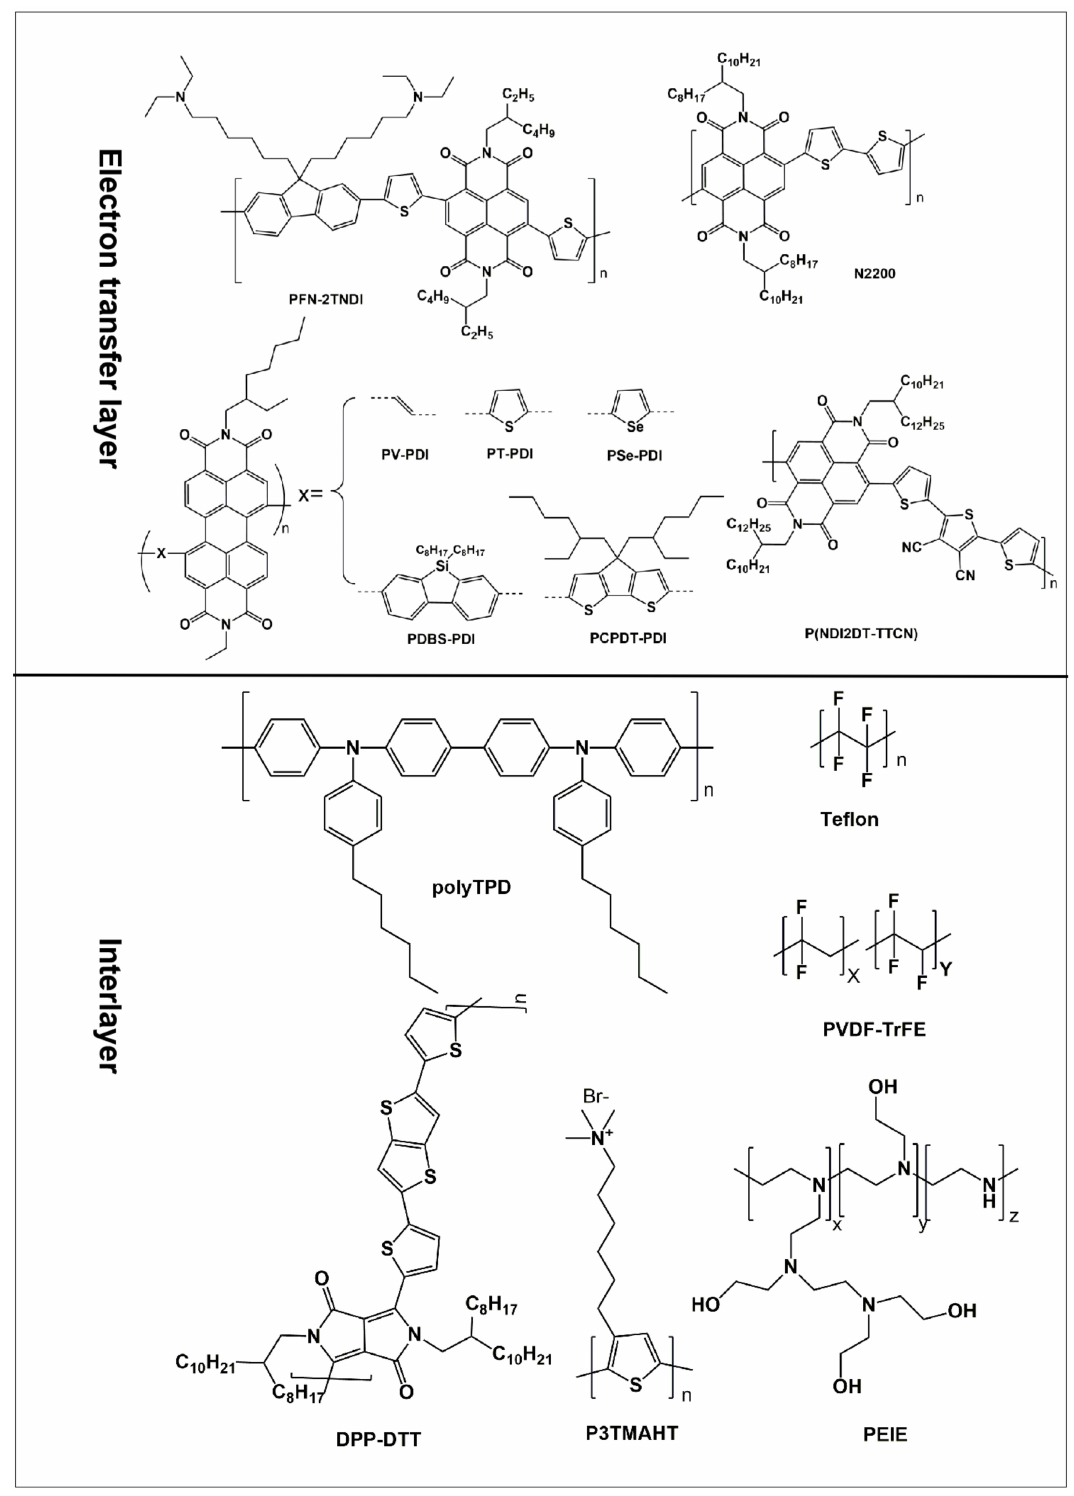
Figure 14. Chemical structures of polymers used to discuss the electron transport layers and